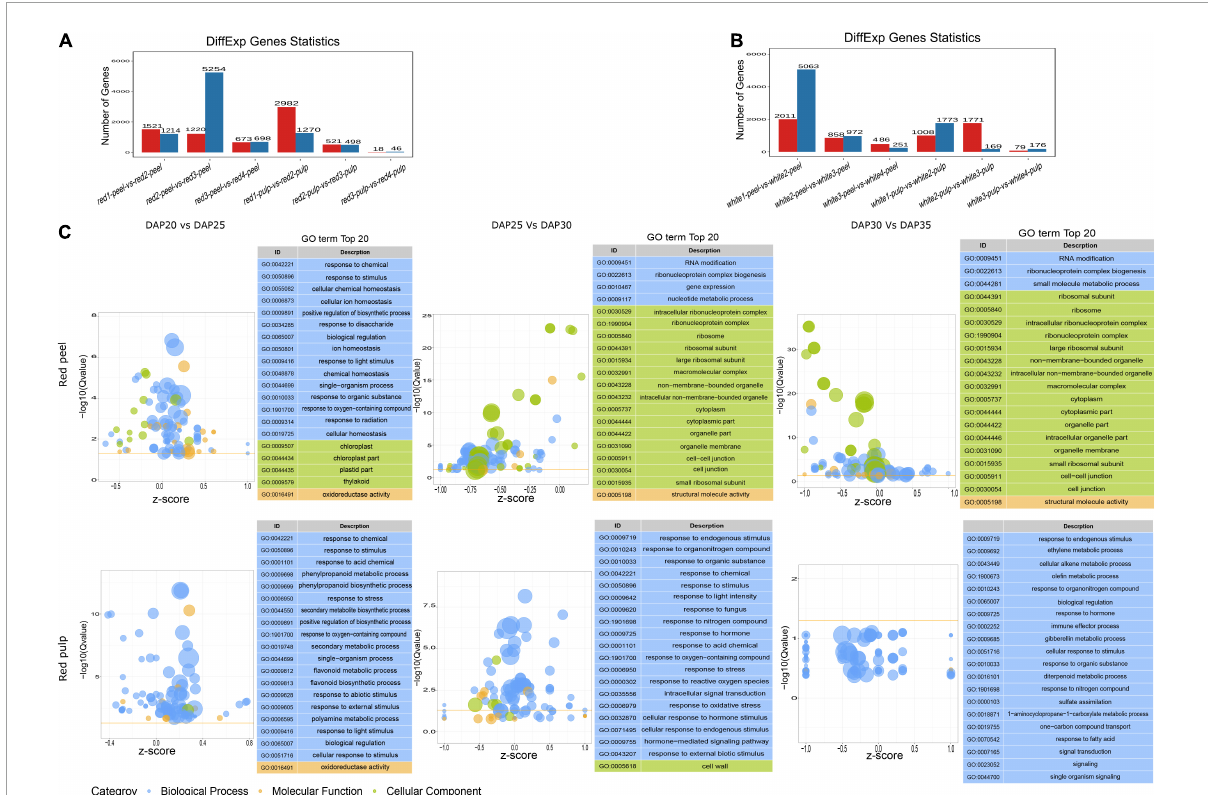
FIGURE3 Differential expressed genes and GO term analysis. (A) The number of DEGs of red pitaya peel and pulp among fruit development. (B) The number of DEGs of white pitaya peel and pulp among fruit development. (C) GO terms of DEGs produced by red peel and pulp across fruit